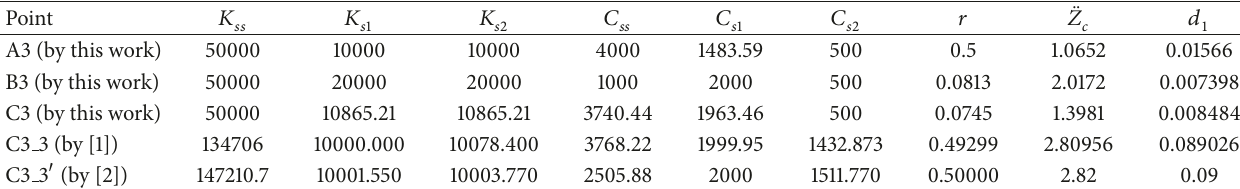
Table 7: Objective function values and trade-off design variables of [1, 2] and this work shown in Figure 16.